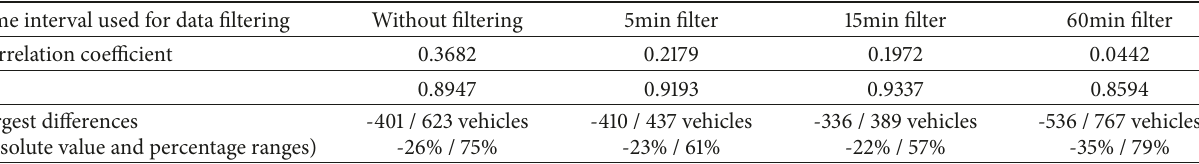
Table 1: Relation between detection and traffic flow for different filters.